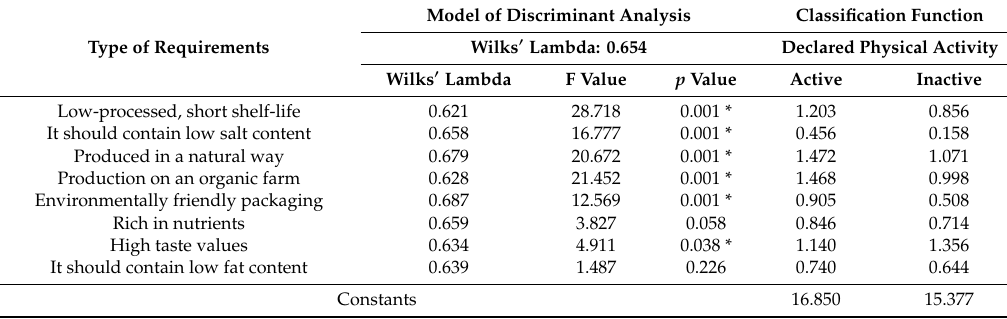
Table 4. Requirements for organic food set by